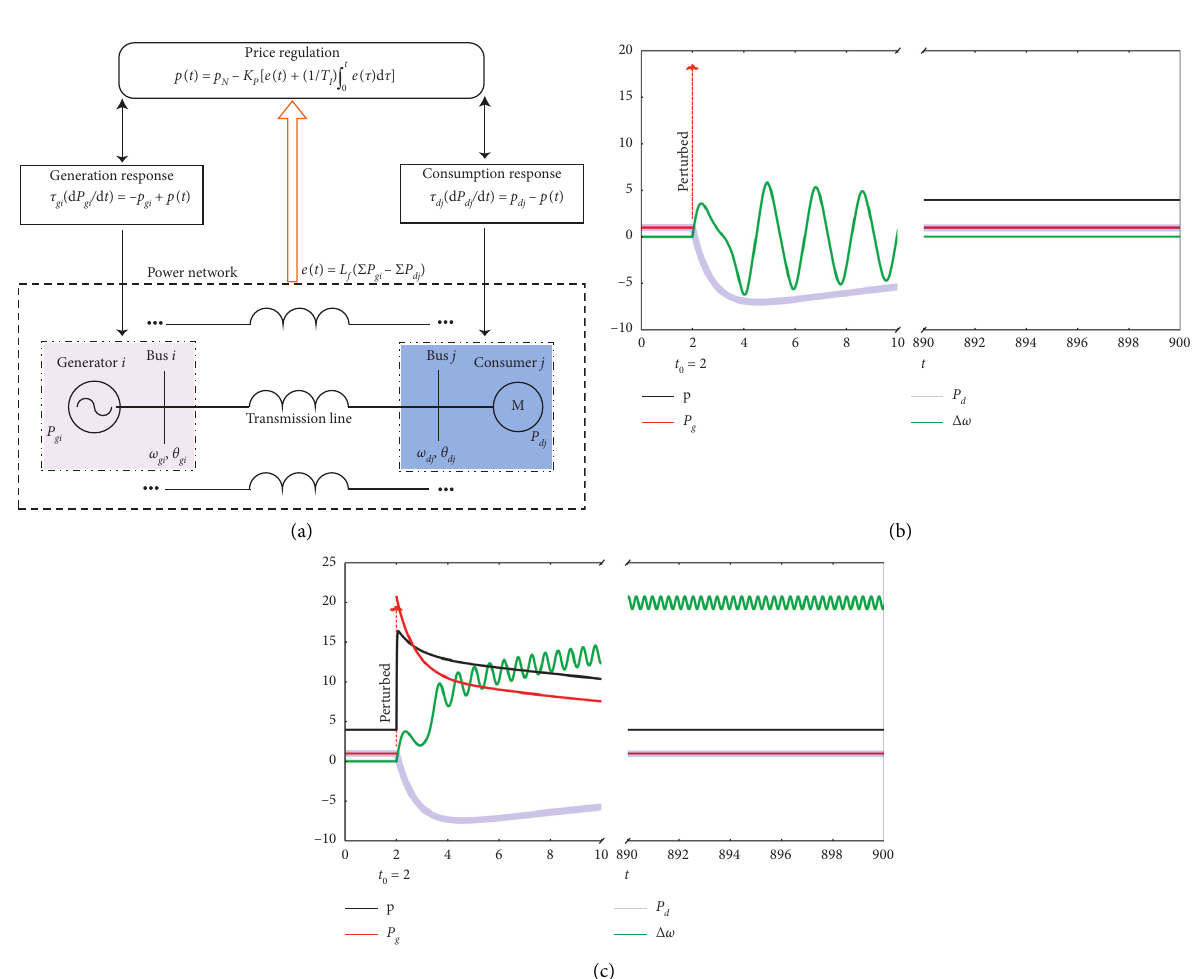
Figure 1: Interpretation of governing dynamics. (a) Schematic diagram for the interactions between different kinds of dynamics. In the two- node model (8), trajectories of the price p , generation P g , and consumption P d are shown in (b) (resp. in (c)) given a perturbation suffered at located inside (resp. outside) the attracting basin of the synchronous state. Parameters are given as K P � 50, T l � 20, T D � 0 . 5, time t 0